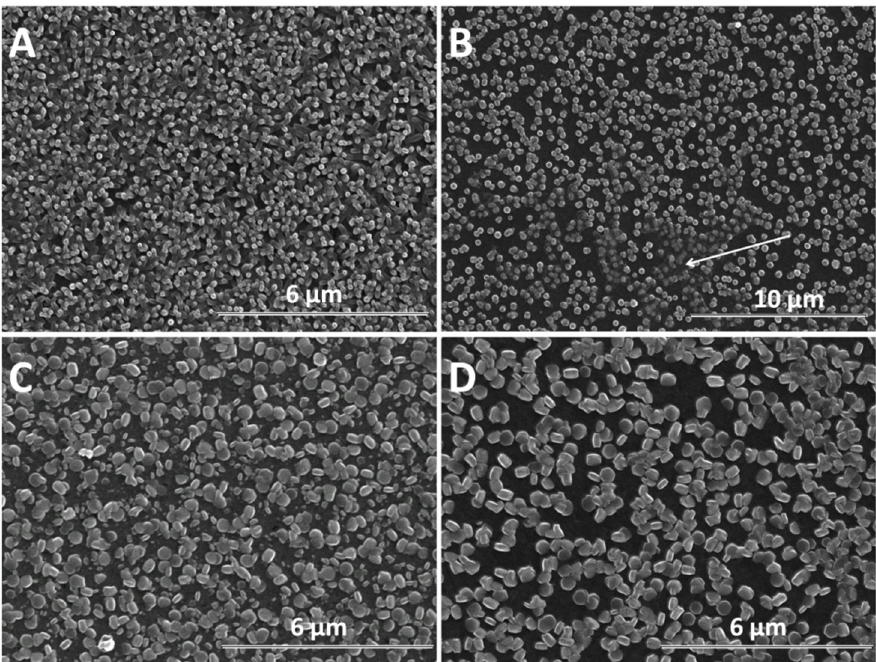
Figure 4. SEM images of ZnO electrodeposited as a function of GO content (mg L − 1 ) at − 1 V for 120 s: 0 ( A ), 2.5 ( B ), 7.5 ( C ), 10 ( D ). Materials 2019 , 12 , x FOR PEER REVIEW